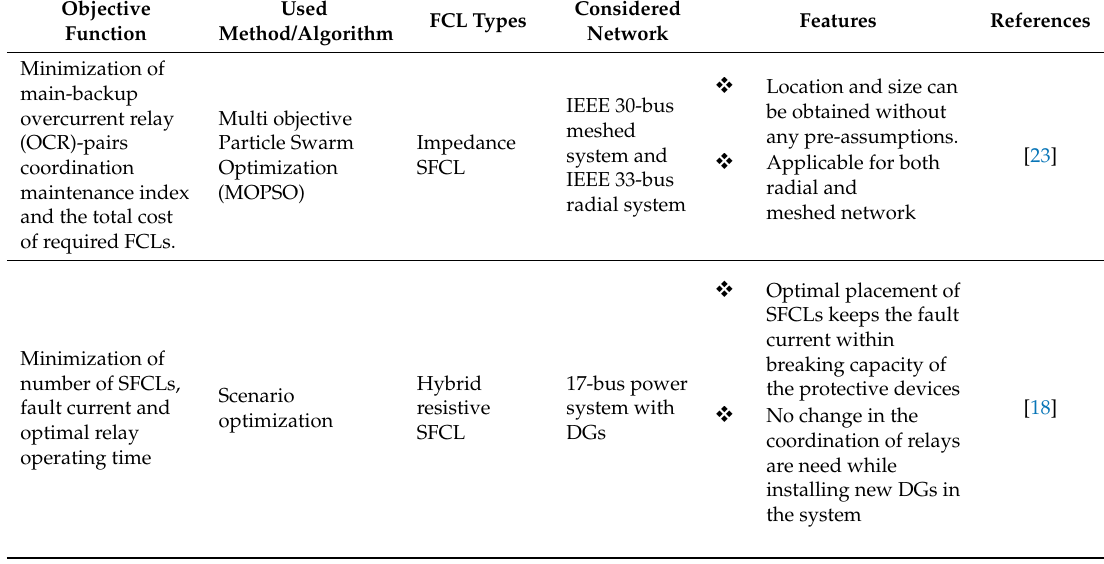
Figure 4. The phases for implementing a N-AHP in SWOT